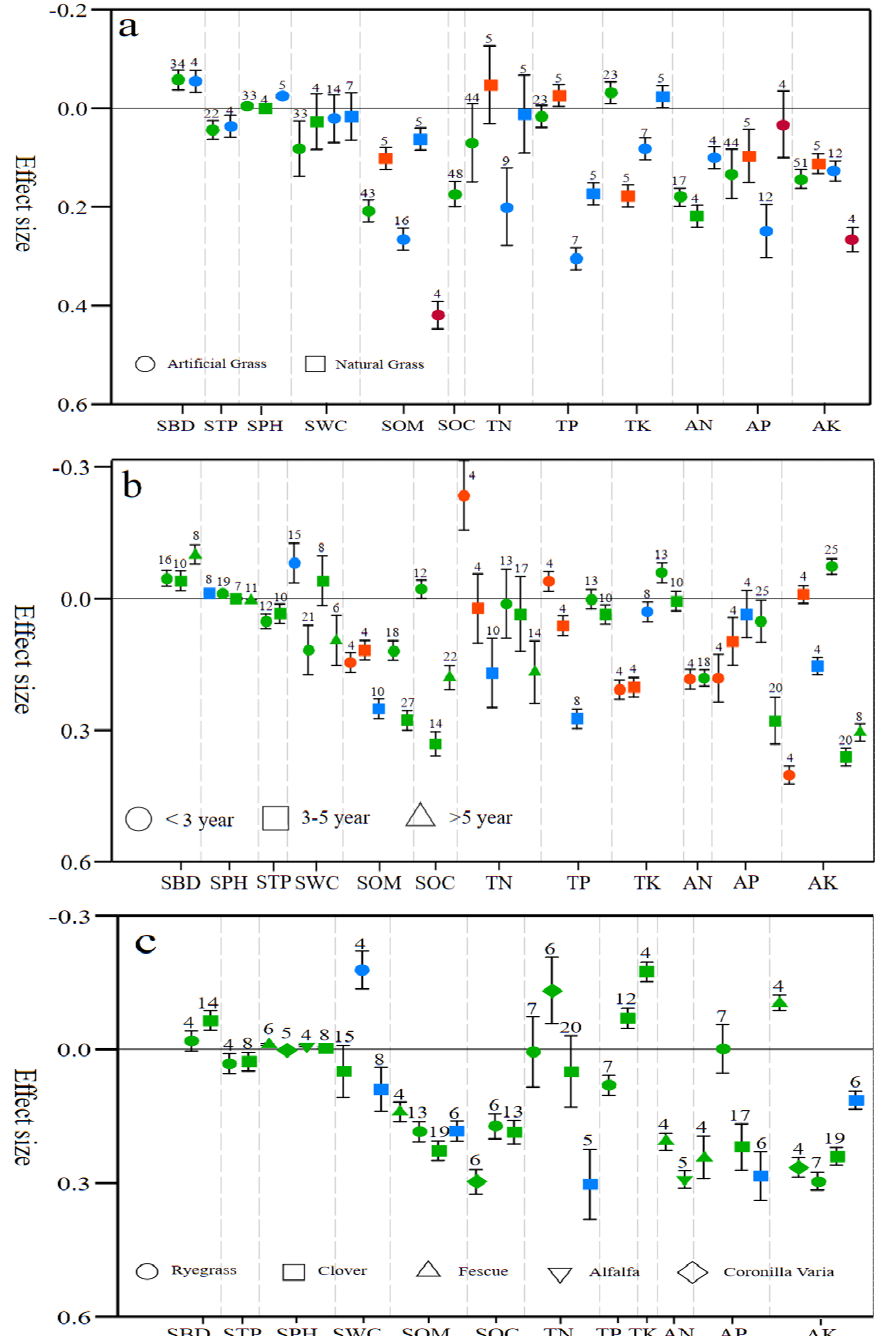
Figure 4. Response of soil physicochemical properties to different influencing factors for apple orchards with living grass mulch according to climate region. ( a ) Mulch methods. ( b ) Continuous grass-growing years. ( c ) Grass varieties. Medium green, orange-red, medium blue and cranberry colors represent warm, temperate semi-humid; warm, temperate arid; temperate, semi-humid; and temperate, semi-arid climate zones, respectively. Weighted means and their 95% confidence intervals of the effect sizes are given. The numbers at the top of the confidence intervals represent the sample sizes. SBD: soil bulk density; STP: soil total porosity, SPH: soil pH; SWC: soil water content; SOM: soil organic matter; SOC: soil organic carbon; TN: soil total nitrogen; TP: soil total phosphorus; TK: soil total potassium; AN: soil available nitrogen; AP: soil available phosphorus; AK: soil available potassium.